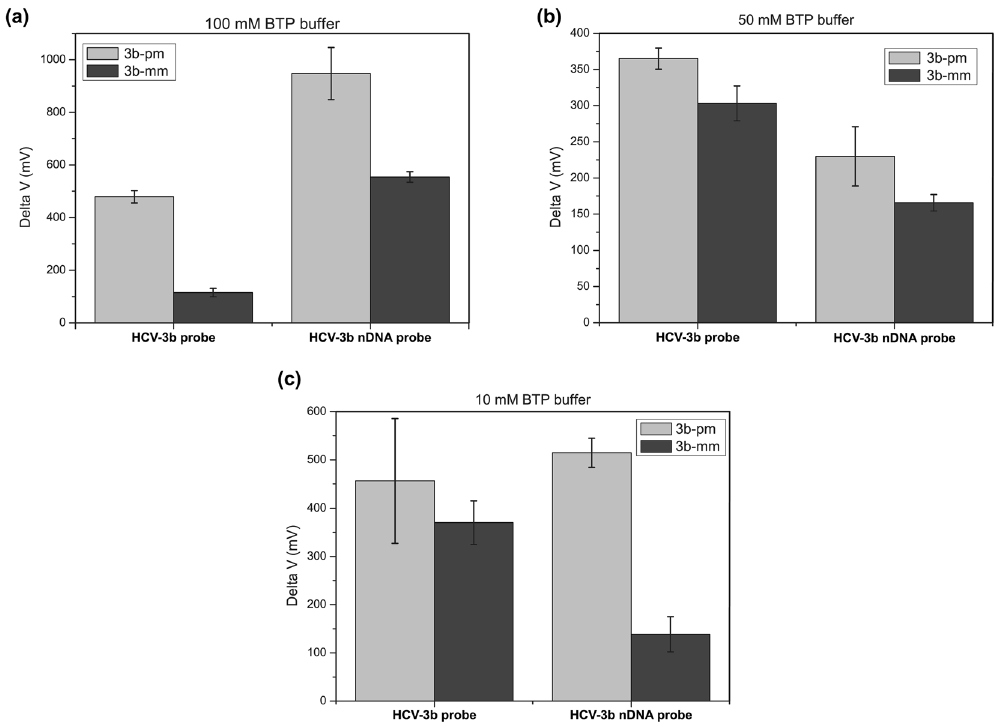
Figure 3. Quantitative data of gate voltage changes produced by probe-target hybridizations in the SiNW FET measurements, which were measured in BTP buffers with the concentrations of 100 ( a ), 50 ( b ), and 10 mM ( c ) at 25